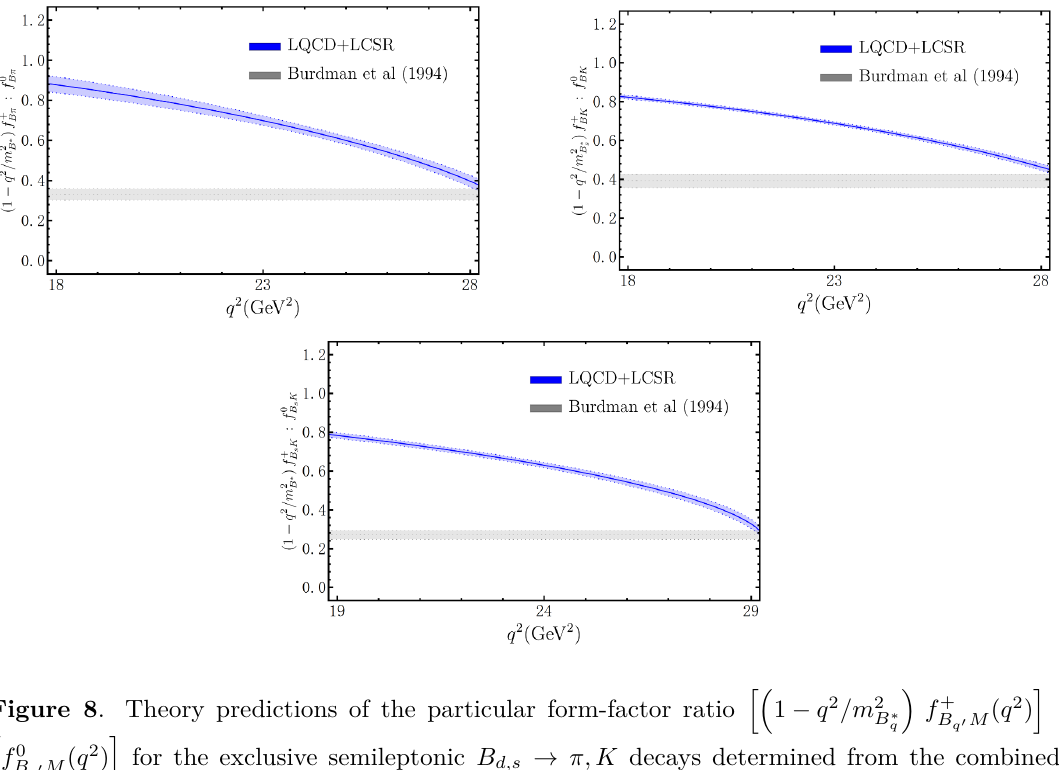
Figure 8 . Theory predictions of the particular form-factor ratio h i ( q 2 ) for the exclusive semileptonic B f 0 B q 0 M z -expansion fit against the LCSR and lattice QCD data points (blue bands) and from the theoretical expectations of the heavy quark spin symmetry and the current algebra technique at NLO in the Λ /m expansion [152] (grey b